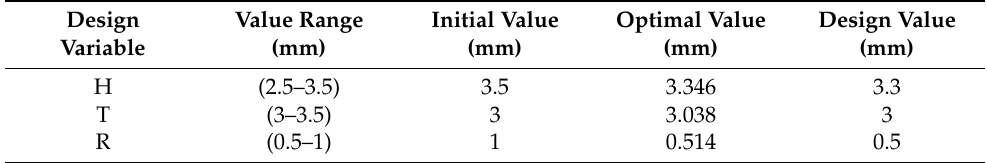
Table 3. Optimization results of the design variable.